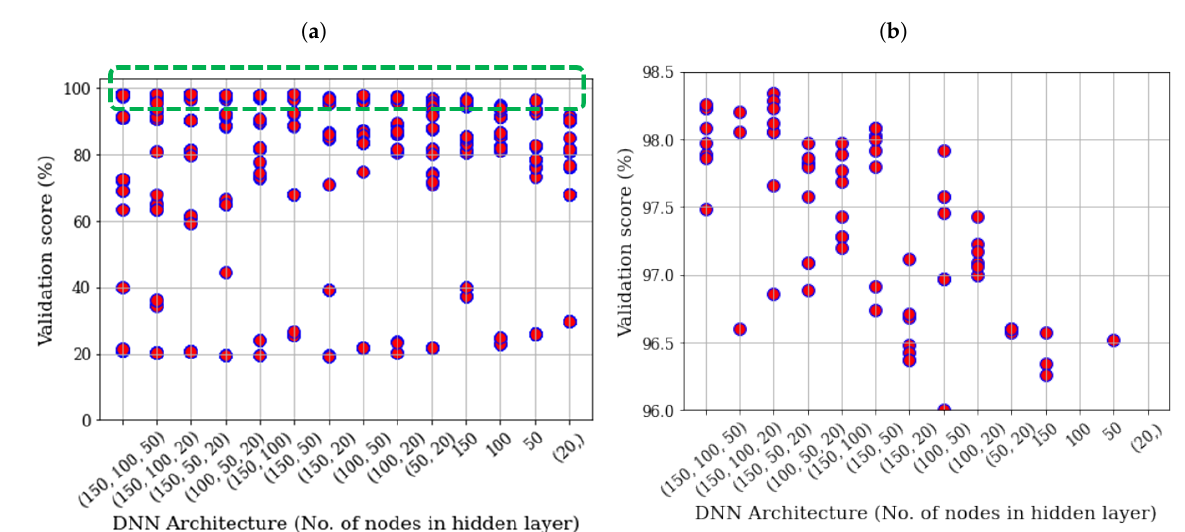
Figure 6. Validation scores of different DNN architectures over a five-fold cross validation: ( a ) a complete assessment view and ( b ) a zoomed view of the highest validation scores.